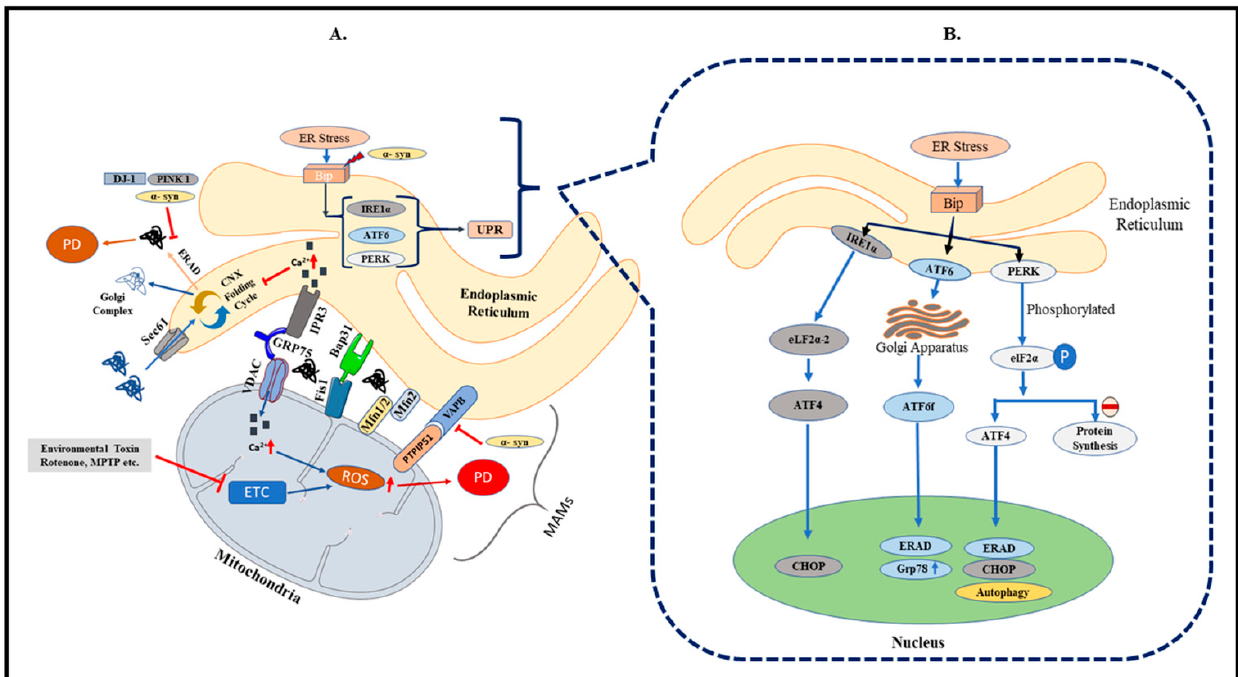
Figure 1. ( A ). An overview of the contact site existing between ER and mitochondria. ER and mitochondria form a close structure that facilitates the movement of Ca 2+ ion and phospholipids, maintains lipid raft, mitochondrial biogenesis, and regulates cellular homeostasis by apoptosis. Several integral proteins located on MAM include IP3R, VDAC 1, which forms a tripartite with GRP75, Fis1-Bap31 tether, Mfn1 and 2 for maintaining mitochondrial biogenesis, and VAPB–PTPIP51. Pathogenic alterations, either in the mitochondria or ER, lead to changes in the MAM structure and vice versa. Mutation in genes associated with PD leads to aggregation and accumulation of misfolded protein in ER and mitochondria and subsequently increases the distance between MAM. ( B ) The unfolded protein response (UPR) is activated as a response to accumulated proteins within the ER. The UPR consists of membrane resident ER stress sensors, namely PERK, IRE1, and ATF6. Stress conditions due to increased reactive oxygen species (ROS), starvation, and altered Ca 2+ concentration lead to activation of the UPR. Under normal conditions, GRP78/BiP forms a complex with the three resident proteins. UPR is initiated when a misfolded protein is detected and bound to GRP78, followed by activation of PERK, IRE1, and ATF6. Initiation of UPR and its resident proteins thereby determine the fate of the encountered misfolded protein. During PD, the UPR function is compromised, which causes ER stress, thereby affecting MAM functions.